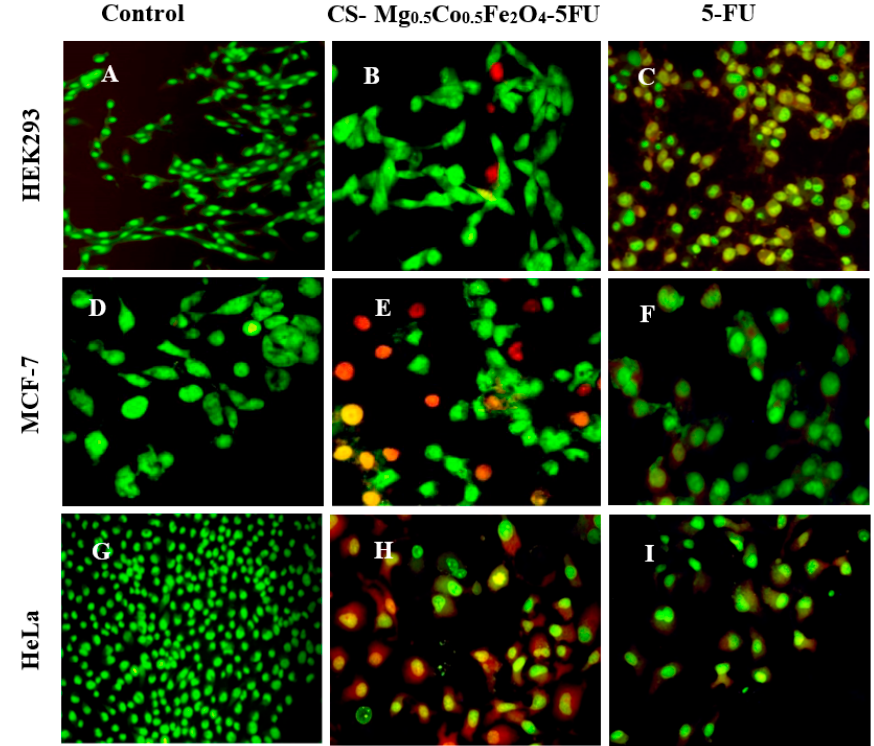
Figure 6. Fluorescent images of AO / EB stained cells ( A ) HEK293 control cells, ( B ) HEK293 cells treated with CS-Mg 0.5 Co 0.5 Fe 2 O 4 -5FU NPs, ( C ) HEK293 cells treated with 5-FU ( D ) MCF-7 control cells, ( E ) MCF-7 cells treated with CS-Mg 0.5 Co 0.5 Fe 2 O 4 -5FU NPs, ( F ) MCF-7 cells treated with 5-FU, ( G ) HeLa control cells, ( H ) HeLa cells treated with CS-Mg 0.5 Co 0.5 Fe 2 O 4 -5-FU NPs and ( I ) HeLa cells treated with 5-FU. Images taken at 20 × magnification. Table 4. Apoptotic indices of free 5-FU and 5-FU-loaded nanocomposites.